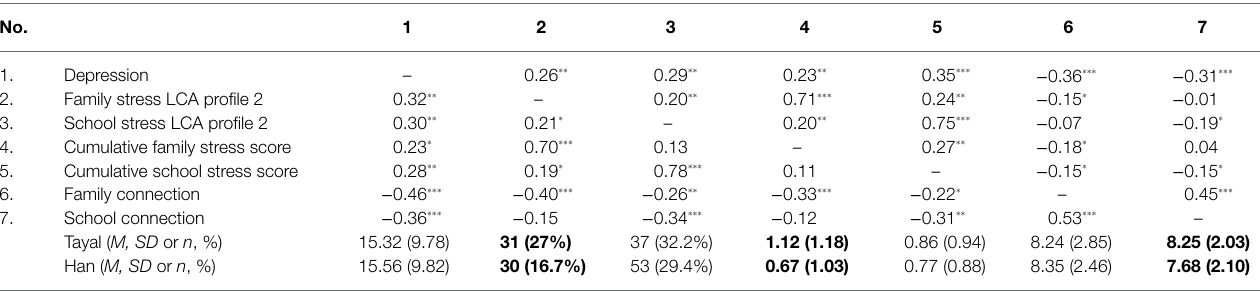
TABLE 5 | Correlations and descriptive information among depression, stress, and connection variables a .